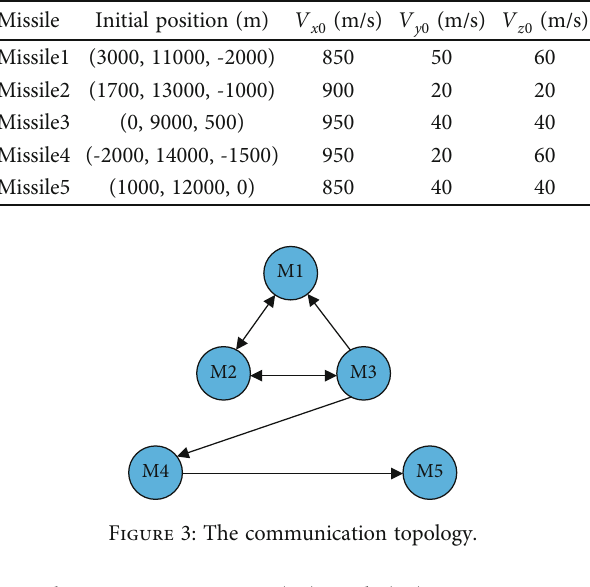
Figure 3: The communication